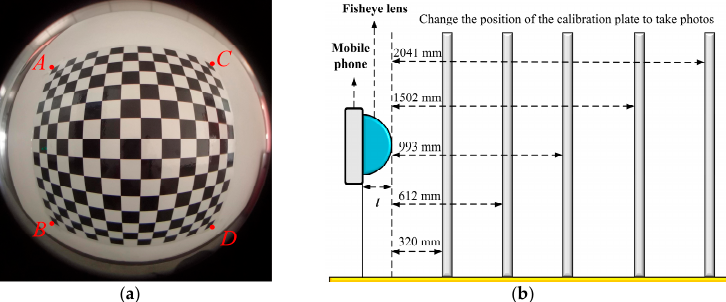
Figure 6. Checkerboard and corner extraction. ( a ) Fisheye image; ( b ) Corner extraction. The following steps were performed: camera calibration, calculation of the distortion coefficient corresponding to all corners in each chessboard, and the average value was taken for subsequent calculations. Five sets of chessboard diagrams with different dis- tances were taken to verify the accuracy of the measurement model, as shown in Figure 7.